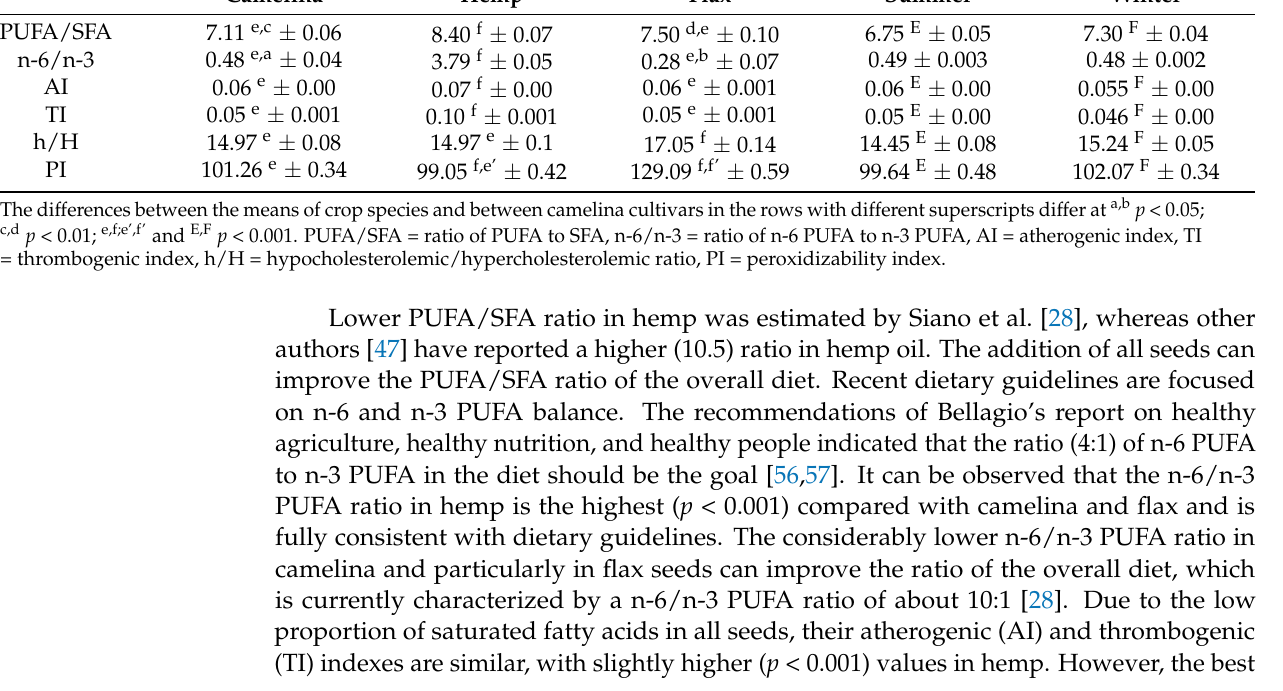
Table 5. Fatty acid ratios and lipid quality indices in seed oil from different oil crop species and camelina cultivars of different sowing seasonality.